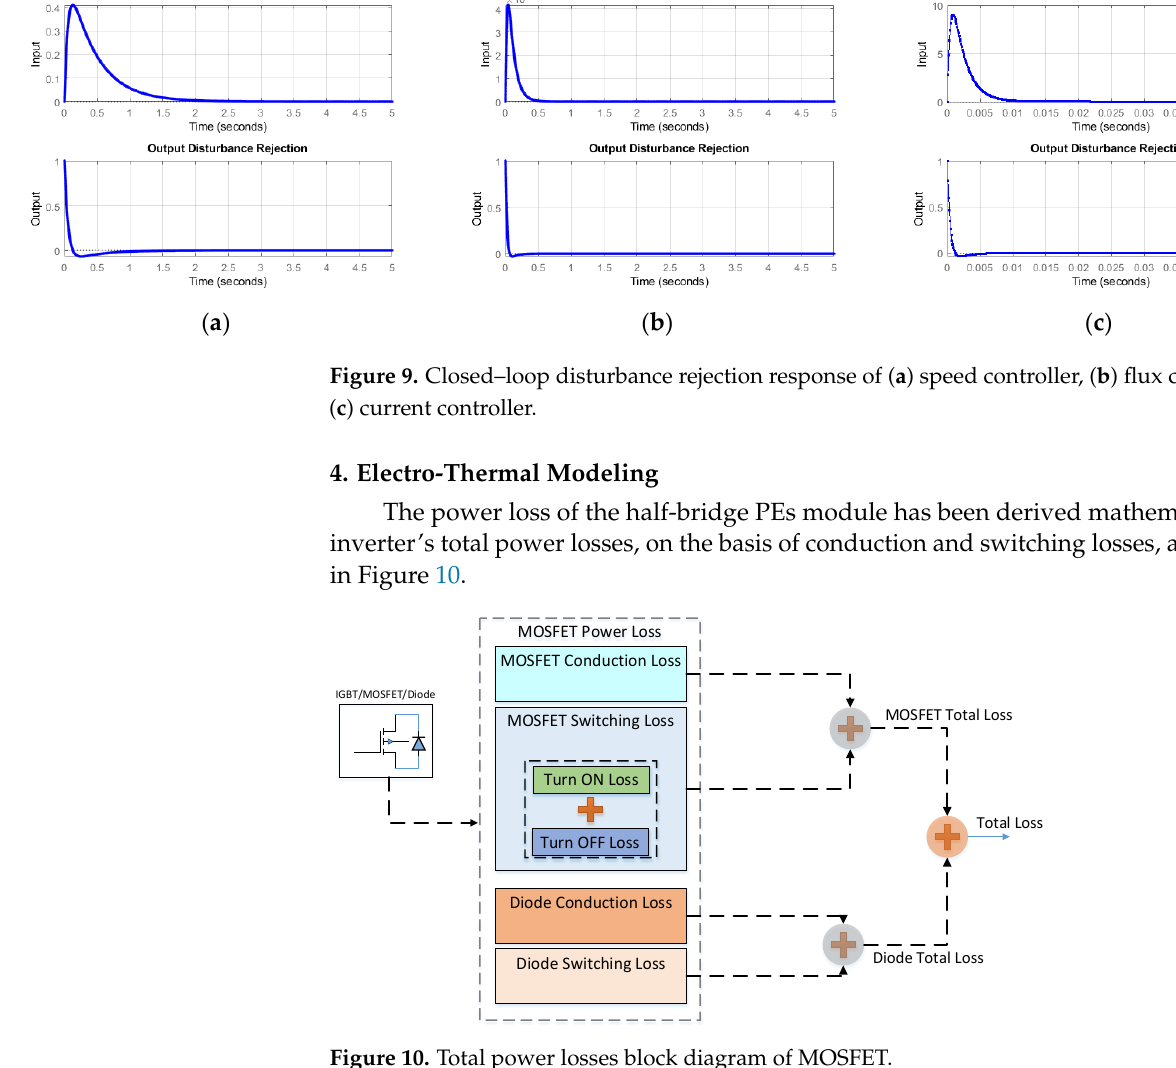
1 a T Figure 8. Feedback current control loop. A closed-loop plant transfer function was used to perform a disturbance rejection analysis. The presence of input and output disturbances provided information about the designed controller. When a disturbance enters the system, the disturbance rejection plot could reveal information about the controller’s effectiveness. The system responded quickly to controller disturbances in order to return to a stable state. The closed-loop step response of input and output disturbance rejection of speed control, current control, and flux control is shown in Figure 9. The formulation of each controller and their tuning is